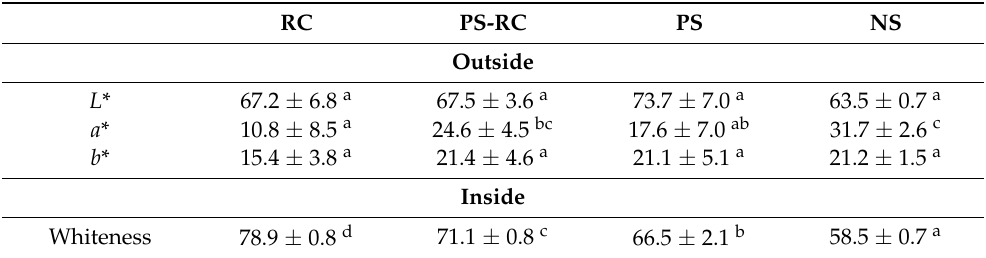
Table 2. Hunter color values of snow crab leg meat and commercial imitation crab